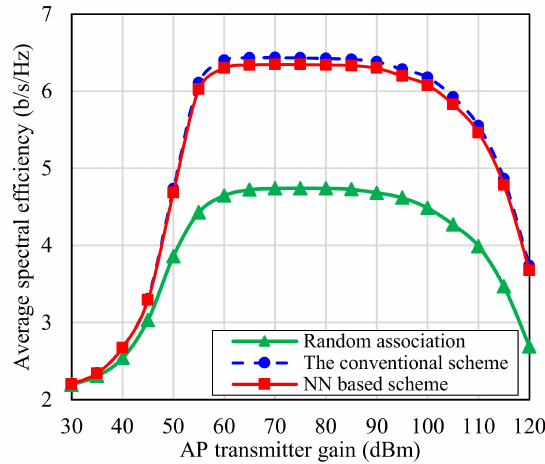
Figure 11. The total average spectral efficiency (SE) against AP transmitter